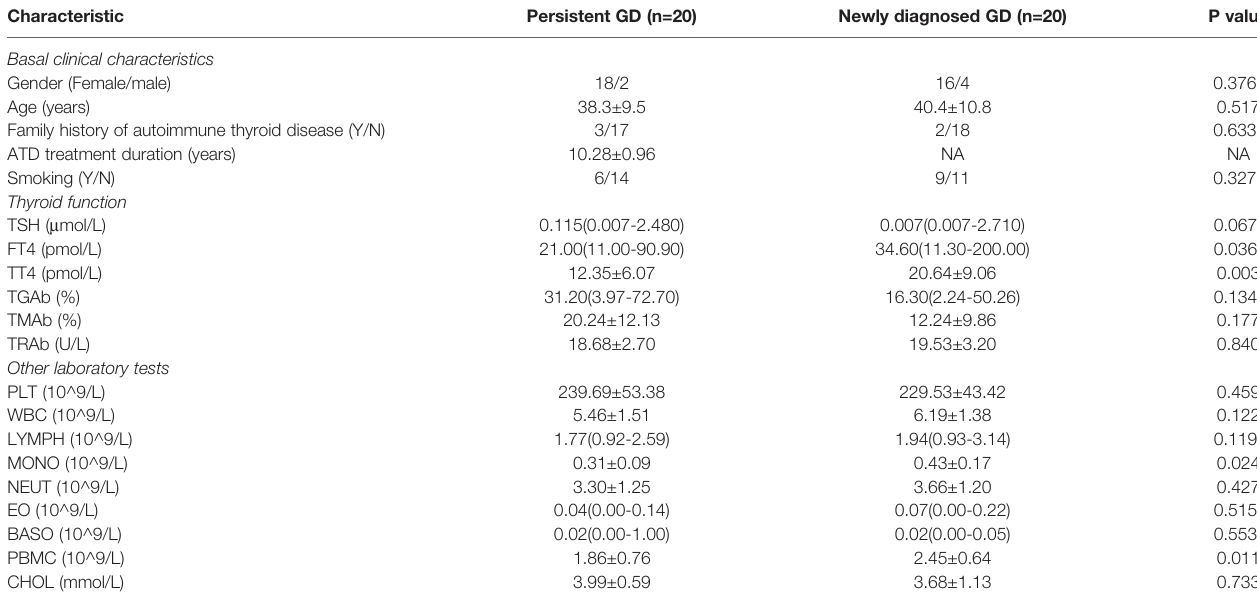
TABLE 1 | Clinical characteristic of enrolled pGD and nGD